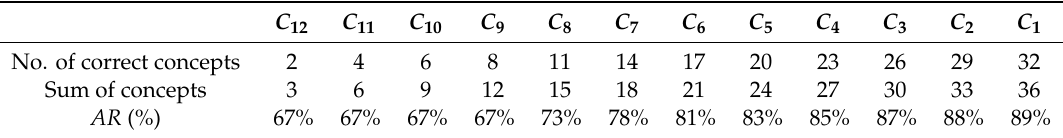
Table 5. Learning achievement results for student 4, who correctly answered Q 1 – Q 24 , Q 26 – Q 29 , Q 31 , Q 32 , Q 35 , and Q 36 .